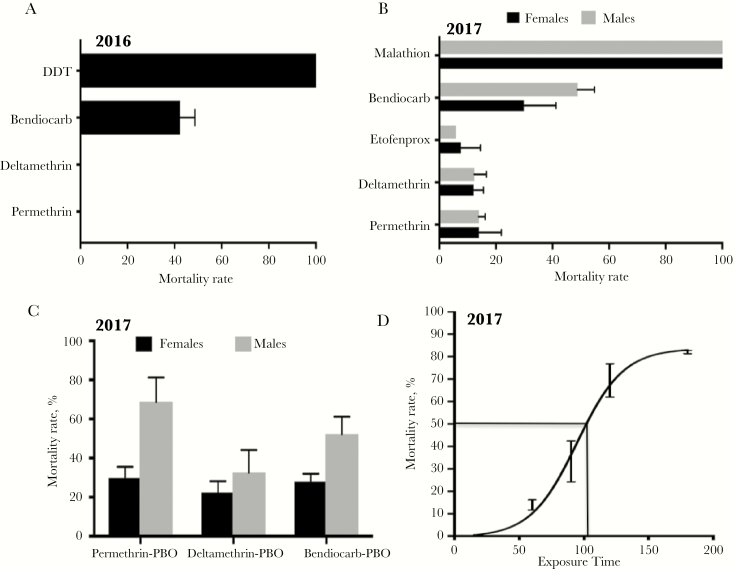
Susceptibility profiles of an Anopheles funestus population from Palmeira, southern Mozambique. A, Susceptibility profile in 2016 for females only. B, Susceptibility profile in 2017 for both males and females. C, Synergist assay with piperonyl butoxide (n = 4). D, Time-point mortality rates for permethrin with estimation of the median lethal time (LT50) at 1 hour 45 minutes. Error bars represent standard error of the mean. Abbreviations: DDT, dichlorodiphenyltrichloroethane; PBO, piperonyl butoxide.